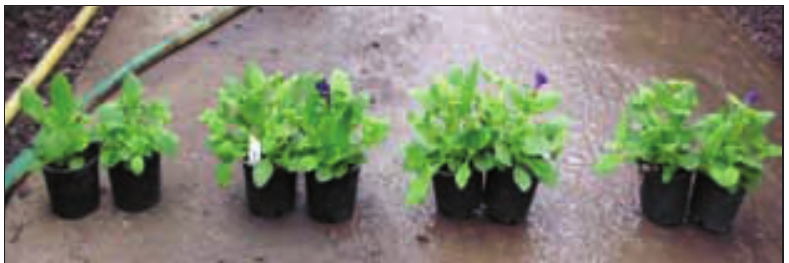
Fig. 2.: Difference among groups at the end of the experiment (from left to right: Control; 0,1% FL; 0,2% FL; 0,3% FL)